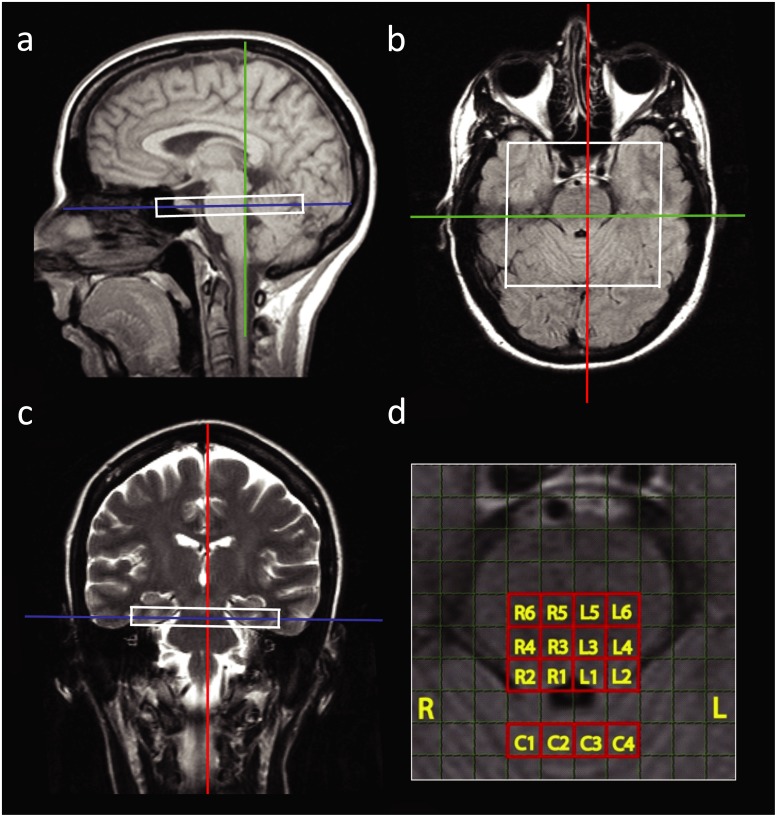
Field of view of the CSI volume (160x160x10 mm3) placement in one subject in sagittal (a), axial (b), and coronal (c) view. Zoomed in axial view of the pons (d) in one subject, sixteen CSI target voxels in the right (R1–R6) and left (L1–L6) and 4 reference voxels in the cerebellum (C1–C4). Each voxel size is 5x5x10 mm3.